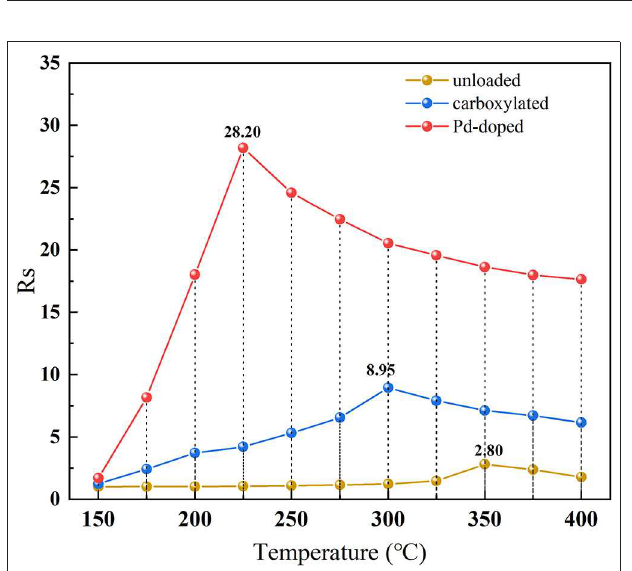
FIGURE 6 | The morphology of nanomaterials. (a–c) The SEM images of the unloaded, the carboxylated, and the Pd-doped SWCNTs. (d–f) The TEM images of the unloaded, the carboxylated, and the Pd-doped SWCNTs.